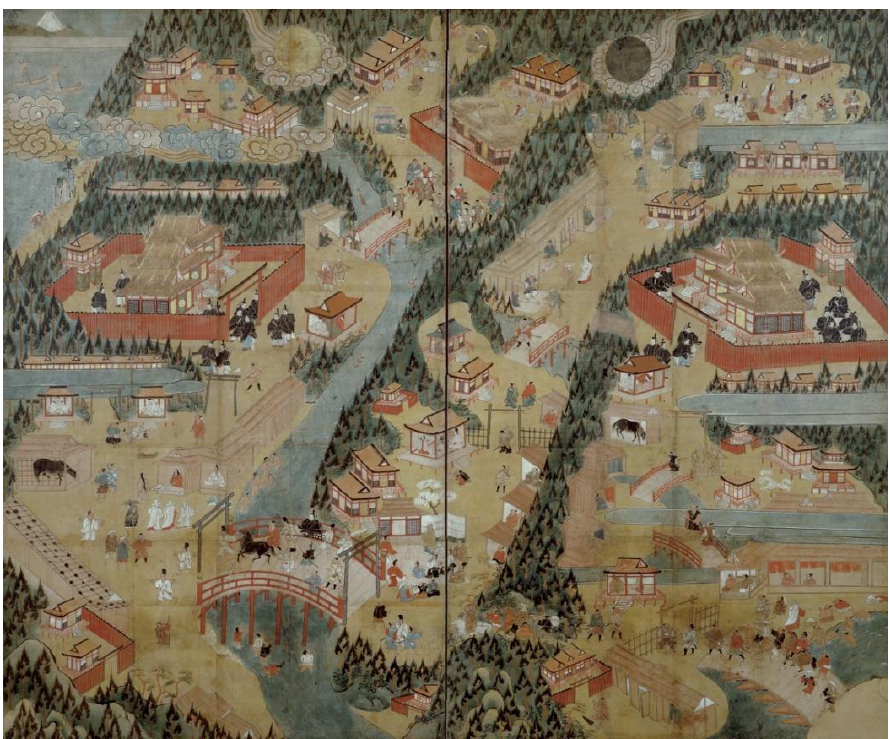
Figure 14. Ise Pilgrimage Mandala , 17th century, former hanging scroll, now mounted as a two-panel folding screen, ink and colors on paper, 59 1 / 2 × 71 in. (151.1 × 180.3 cm). Kimiko and John Powers Collection,